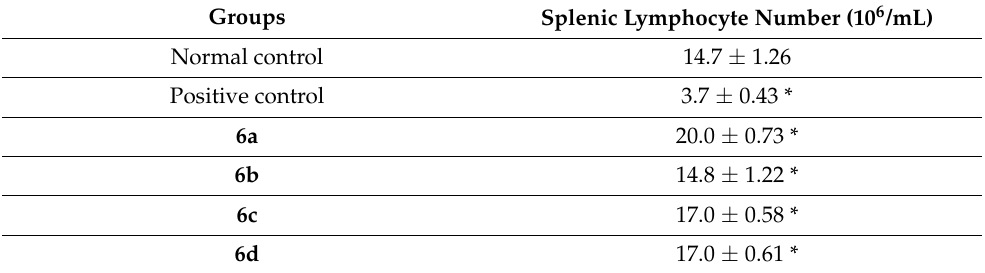
Table 7. Effect of indoloquinoline derivatives on splenic lymphocyte number in the spleen of EAC bearing